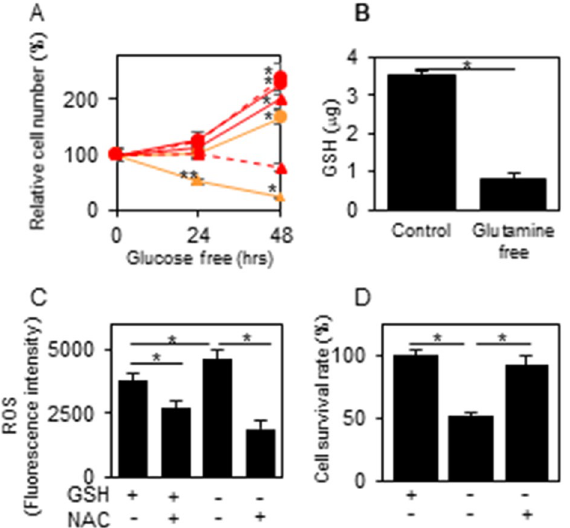
Figure 4. Effects of glutamine depletion on cell survival in XTC.UC1, TPC1 and TPC1 ρ0 cells ( A ), and on GSH and ROS productions and cell survival in XTC.UC1 cells treated with/without NAC ( B – D ). GSH and ROS measurements and cell number measurements were performed as described in the “Materials and methods”; briefly, the cells were cultured in glutamine-containing or free medium for 48 h in ( B ), and in glutamine- containing or free medium with/without 4 mM NAC for 48 h in ( C , D ). In ( A ): red circles with solid lines, TPC1/ glutamine (+); red triangles with solid lines, TPC1/ glutamine free; red circles with broken lines, TPC1 ρ0 cells/ glutamine (+); red triangles with broken lines, TPC1 ρ0 cells/ glutamine free; yellow circles, XTC.UC1/ glutamine (+); yellow triangles, XTC.UC1/ glutamine free. Data are presented as means ± SE. In ( A ): * and **, p < 0.01 and 0.05, respectively, vs. 0 h; in ( B – D ): *, p <